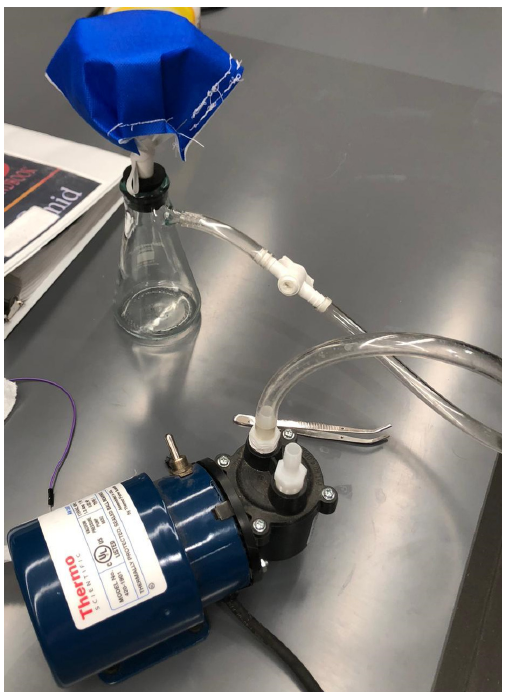
Figure 5. Measurement of airborne particle absorption capability.